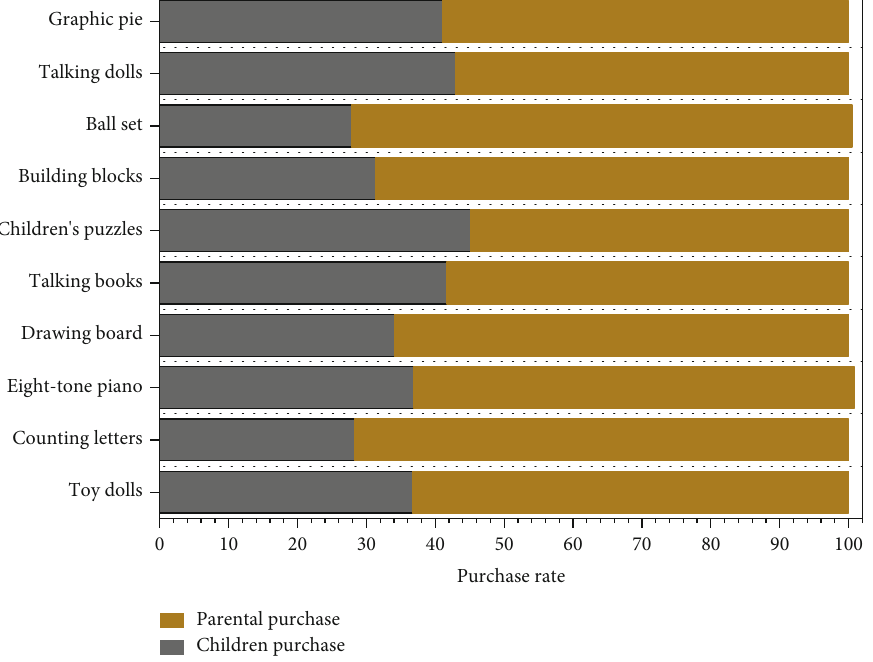
Figure 2: Toy purchases and children ’ s preference for toys.